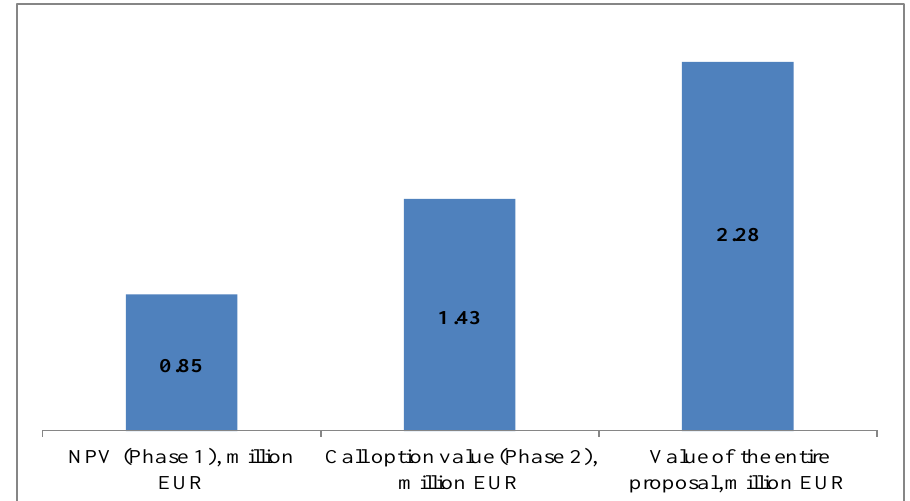
Fig. 2. The value of the strategic investment program (Source: Calculated by the